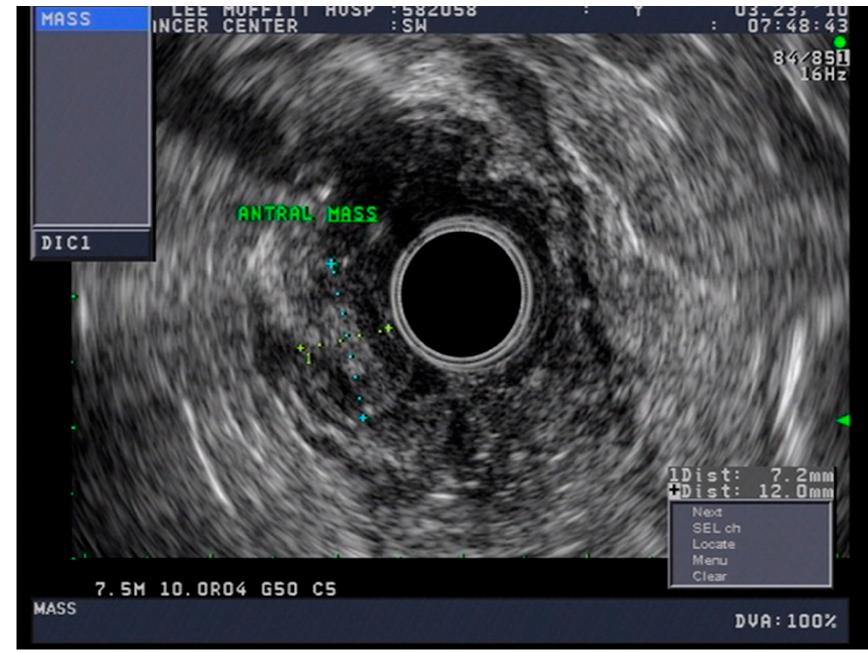
Figure 11. Early gastric cancer; EUS image polypoid lesion T1N0.